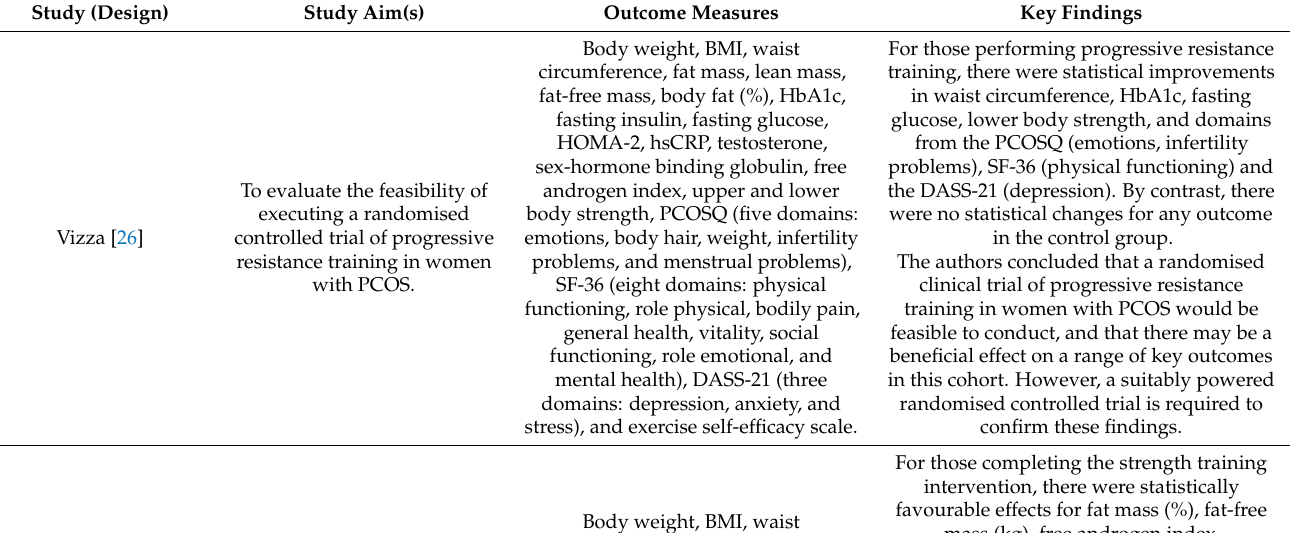
Table 4. Objectives, outcomes, and key findings from included